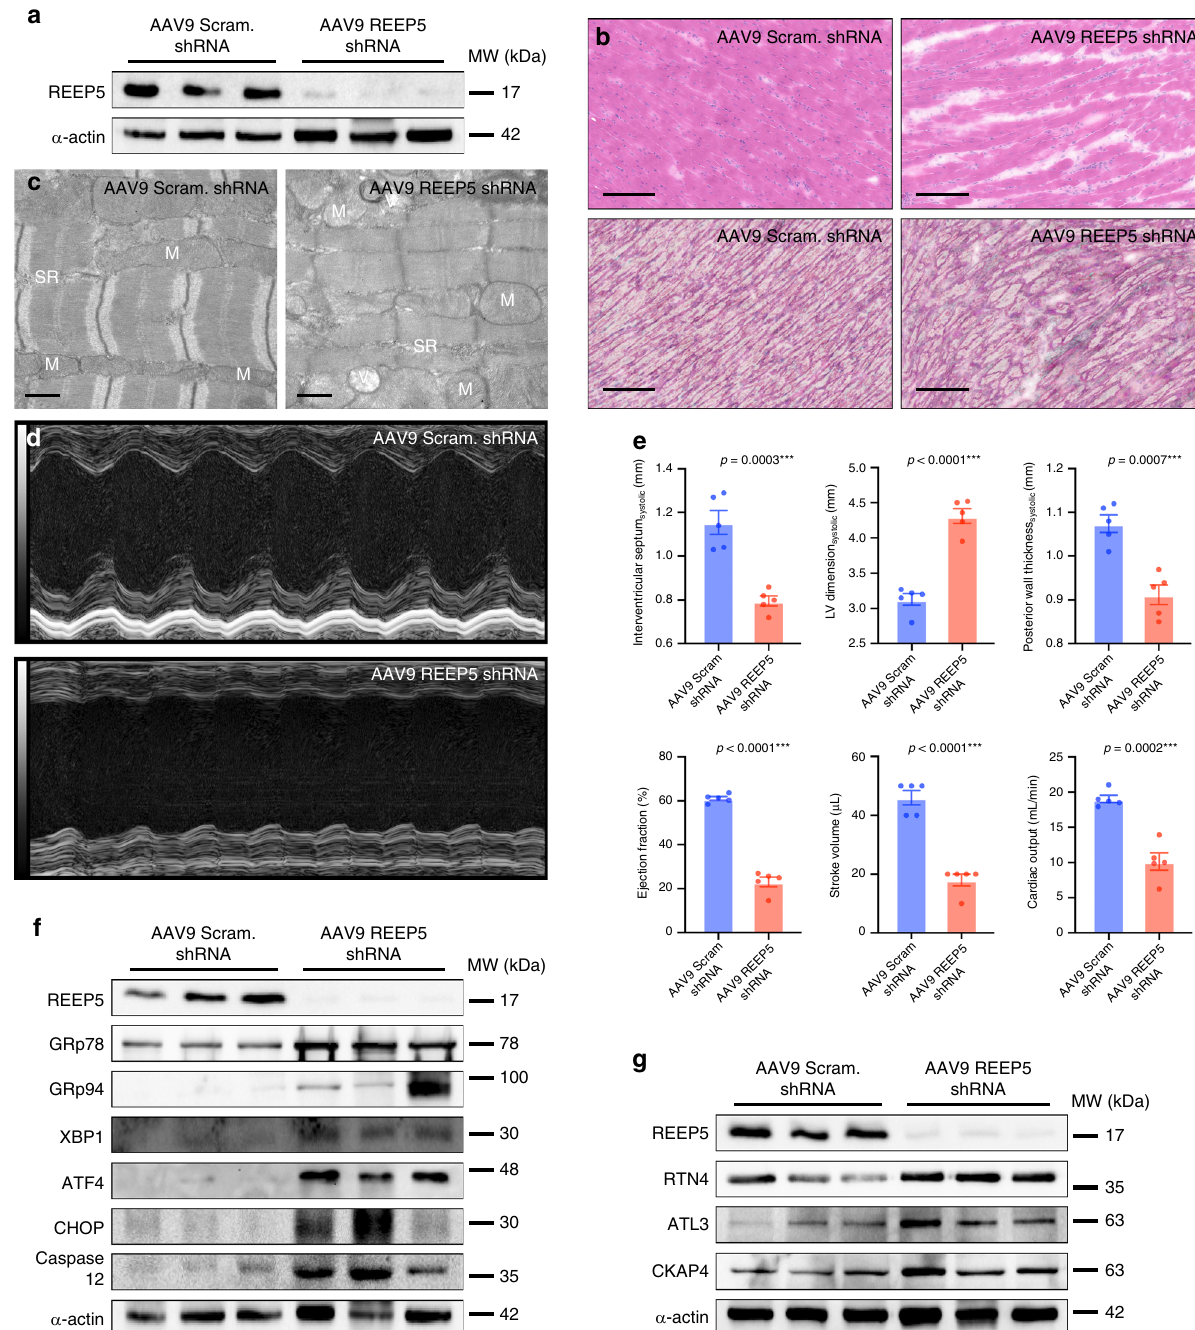
Fig. 9 In vivo AAV9-mediated REEP5 depletion in mice results in increased cardiac fi brosis, activated cardiac ER stress, cardiac dysfunction, and death. a Immunoblot analysis of AAV9-mediated REEP5 depletion in mice 4 weeks post viral infection. b Histological analyses of AAV9 Scram shRNA and REEP5 shRNA injected mouse hearts at 4 weeks post viral infection. Top panels: H&E, bottom panels: Masson ’ s trichrome stain. Scale, 20 μ m. All